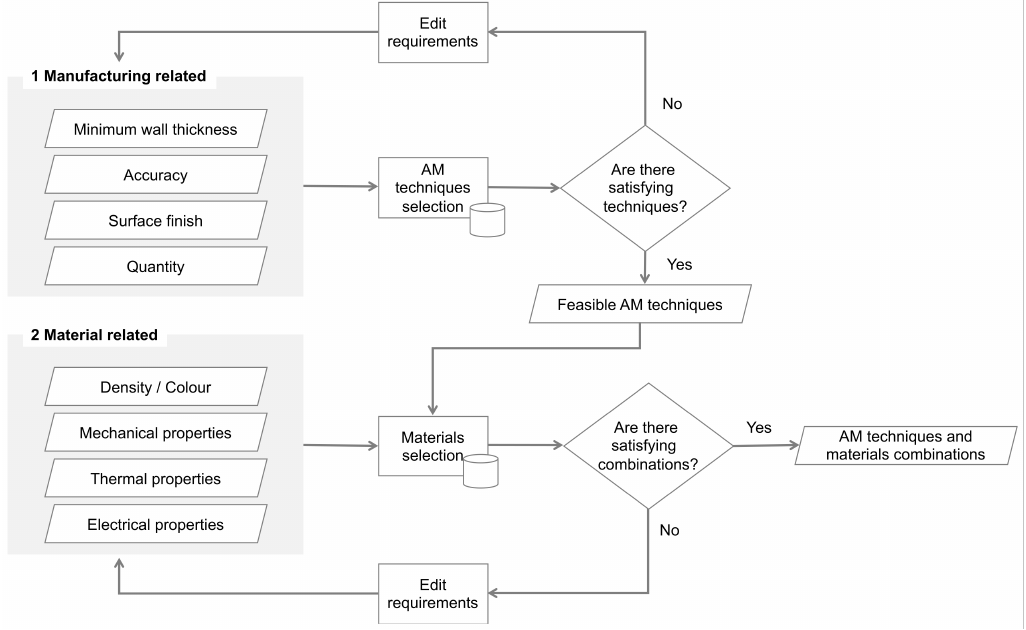
Figure 4. AM preliminary techniques selection (at part